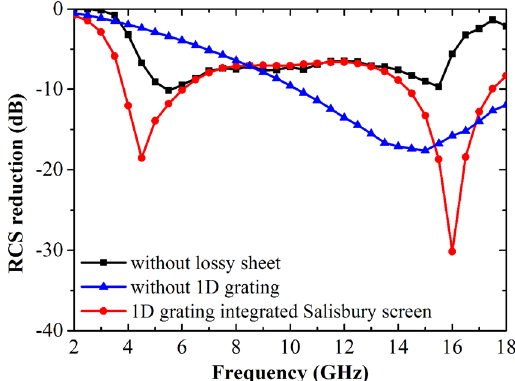
Figure 2. Simulated RCS reduction performance of the designed 1D grating integrated Salisbury screen.